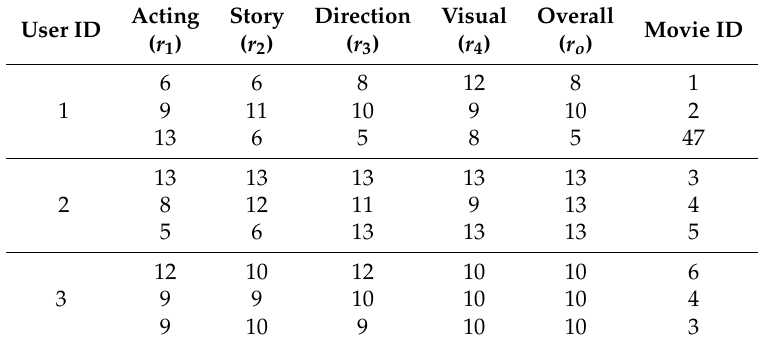
Table 2. Modified sample of the Yahoo!Movies data set for multi-criteria recommender